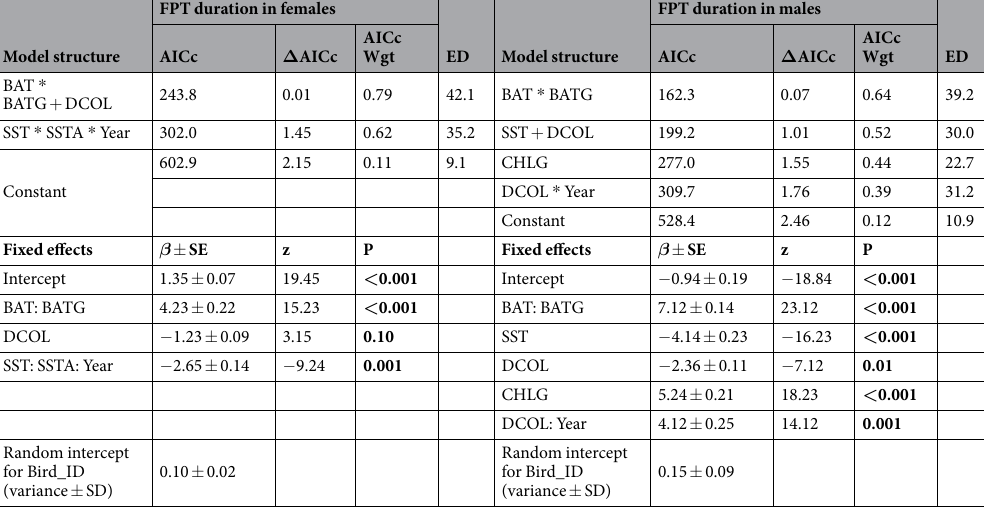
Table 4. Parameter estimates ( ± SE) from Generalized Additive Mixed Models (GAMMs) fitted to the Area Restricted Search behaviour (i.e. First Passage Time – FPT – duration; proxy of foraging activity) of female and male Cory’s shearwaters showing the ranking on the candidate models based on the corrected Akaike Information Criteria (AICc). All evaluated models included individual identity as a random factor. Models are ordered by the AIC value. Presented are the habitat variables in the top-ranked models ( Δ AICc < 2). ED – Explained deviance (%); BAT – Bathymetry (m); BATG –BAT gradient (%); SST - Sea Surface Temperature (°C); SSTG –SST gradient (%); CHL – Chlorophyll a concentration (mgm − 3 ); CHLG – CHL gradient; DCOL – Distance to colony (m). Year – 2010–2015. Significant results in bold.